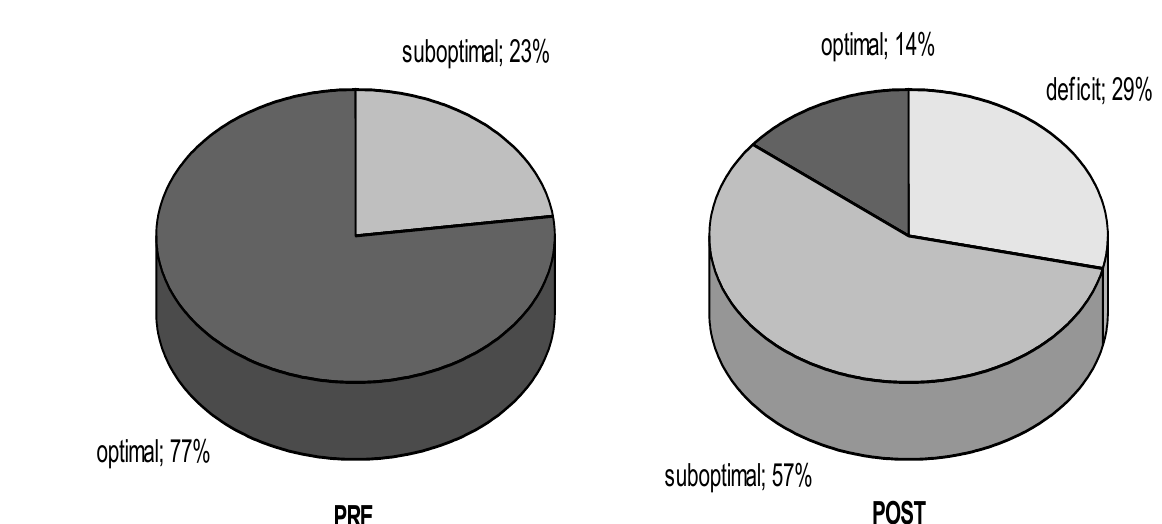
Figure 2. Percentage distribution of the number of footballers with different concentrations of 25(OH)D in blood serum at the end of summer (PRE) and at the end of autumn (POST).